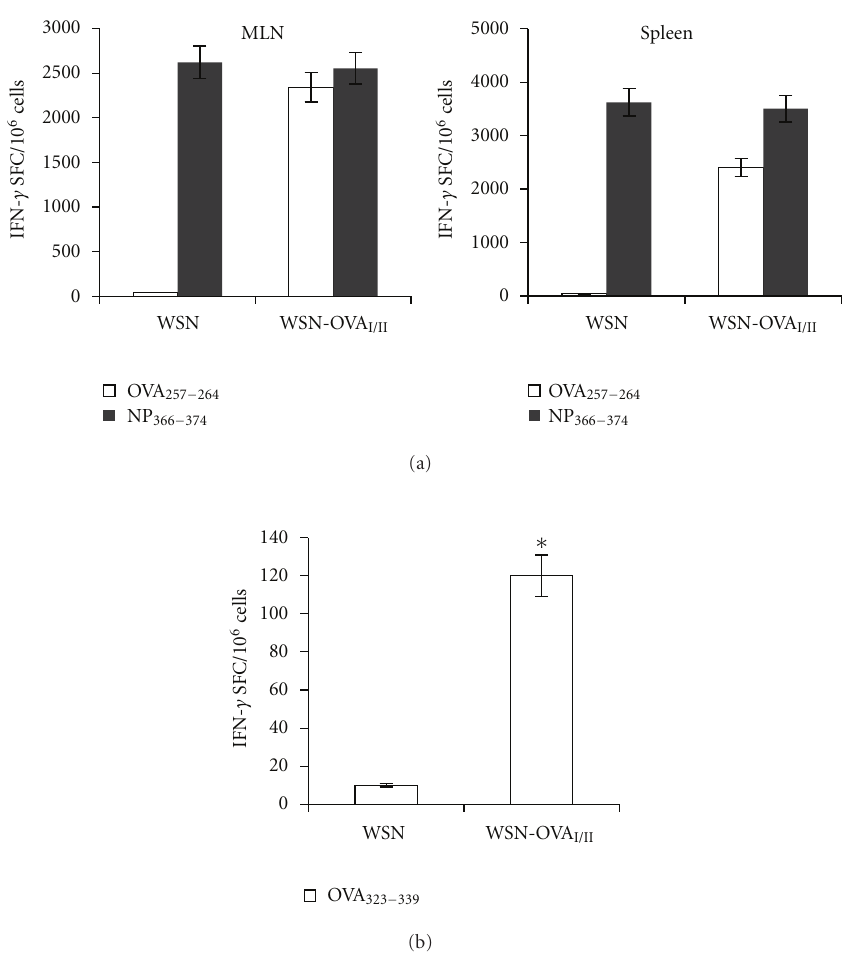
Figure 4: T cell responses in WSN-OVA I / II virus-infected mice. C57BL/6J mice were immunized i.n. with 5 × 10 2 PFU of WSN virus or 3 × 10 5 PFU of WSN-OVA I / II virus, and sacrificed on day 9 for measuring epitope-specific CD8+ T cell responses in mediastinal lymph nodes (MLN) and spleens (a) and CD4+ T cell responses in MLN (b), respectively, by use of an IFN- γ ELISPOT assay with the indicated peptides. The values presented are averages of triplicate wells; the error bars indicate the standard deviation. The data are representative of three experiments. ∗ P < 0 . 05 comparing WSN- versus WSN-OVA I / II -infected